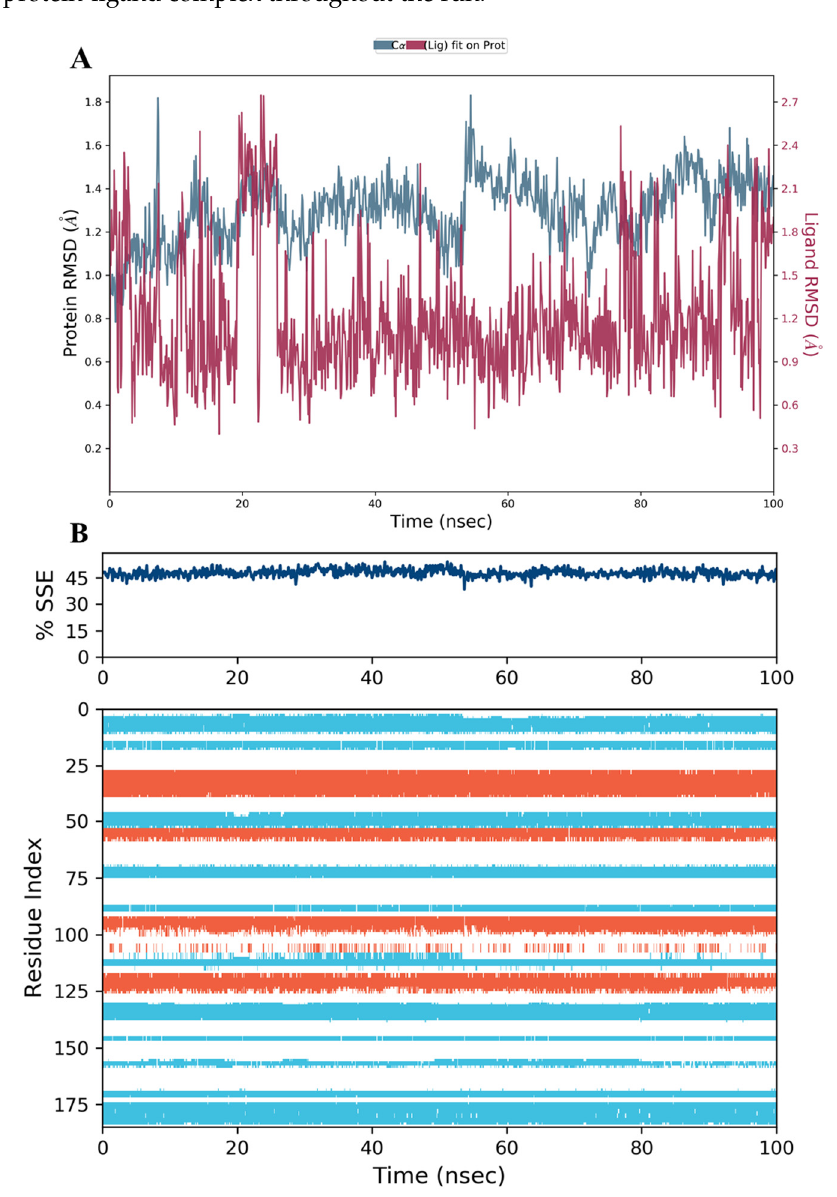
Figure 11. ( A ) The RMSD plot for the reference inhibitor SRI-9662 complexed with hDHFR (PDB: 1KMV) over a 100 ns simulation time; ( B ) Stability of the hDHFR secondary structure over 100 ns of MD simulation when complexed with SRI-9662 . Protein secondary structure elements (SSE) like alpha-helices (orange color) and beta-strands (light blue color) were monitored during the simulation. The upper plot reported SSE distribution by residue index across the protein structure, and the plot at the bottom monitored each residue and its SSE assignment over the simulation time.